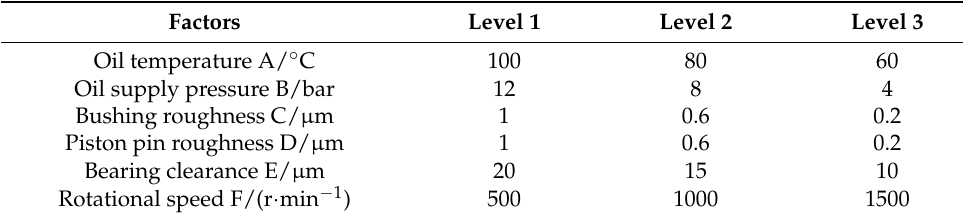
Table 4. Orthogonal experiment table.